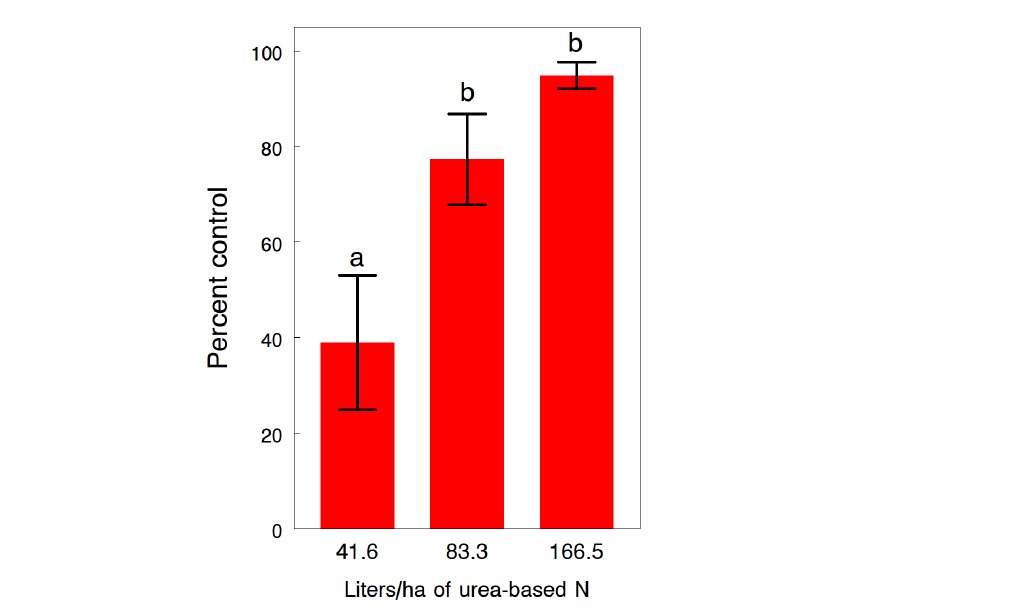
Figure 5. Effects of banded applications of pelleted 4% metaldehyde bait (Deadline Bullet, AMVAC Chemical Corp., Los Angeles, CA, USA) and broadcast dry granular applications of potash on the percentage and severity of plant damage of the gray garden slug, Deroceras reticulatum . Means (±SEM) are presented for studies conducted at two University of Maryland research farms in 1994. Pairs of means within each study with different letters are significantly different at the 5% probabil ‐ ity level.